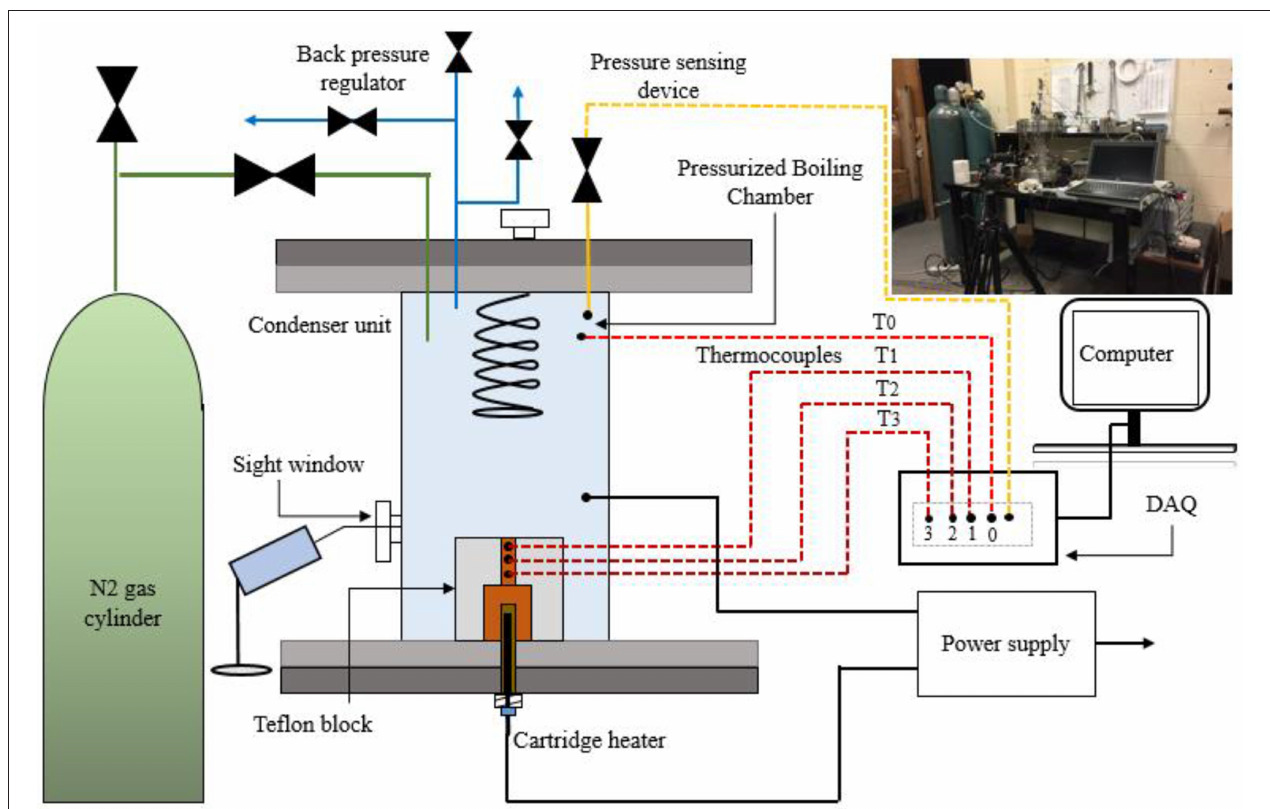
FIGURE 4 | The schematic of high-pressure pool-boiling experimental setup chamber with the data acquisition system, back pressure regulator valve, nitrogen gas cylinder, power supply, heater arrangement, and the sight window with the camera for bubble visualization during boiling. The image of the initial setup of high-pressure pool-boiling is also shown at the top